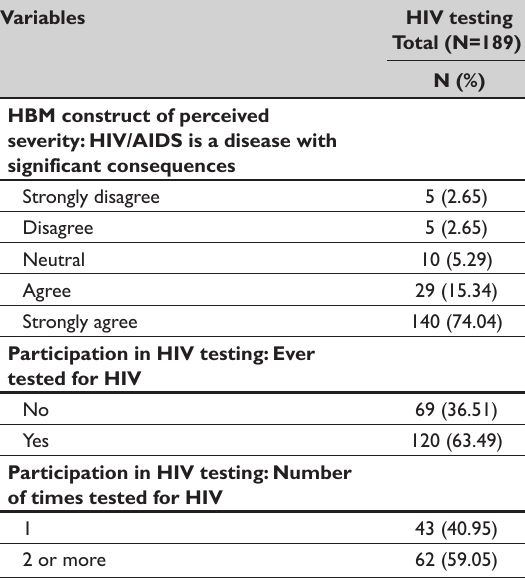
Table 1: ( Contined ) Table 2: Descriptive statistics of